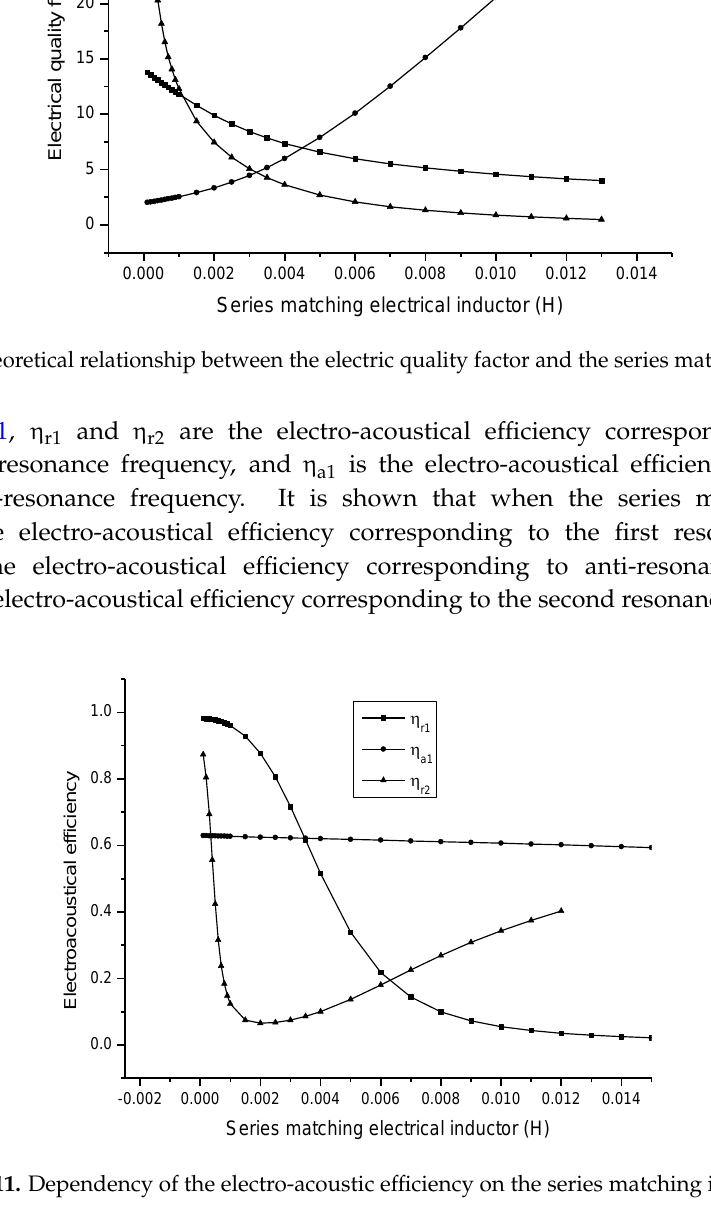
Figure 9. Dependency of the effective electromechanical coupling coefficient on the series matching inductor.